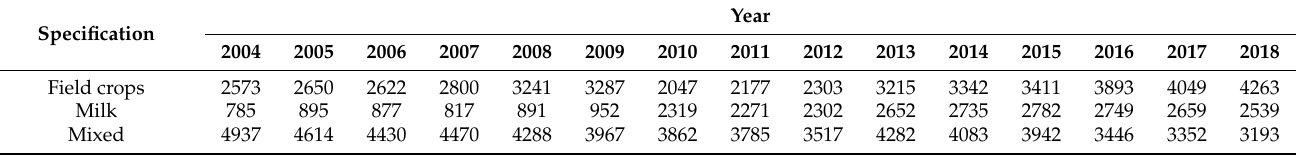
Table A1. Number of farms in 2004–2018.